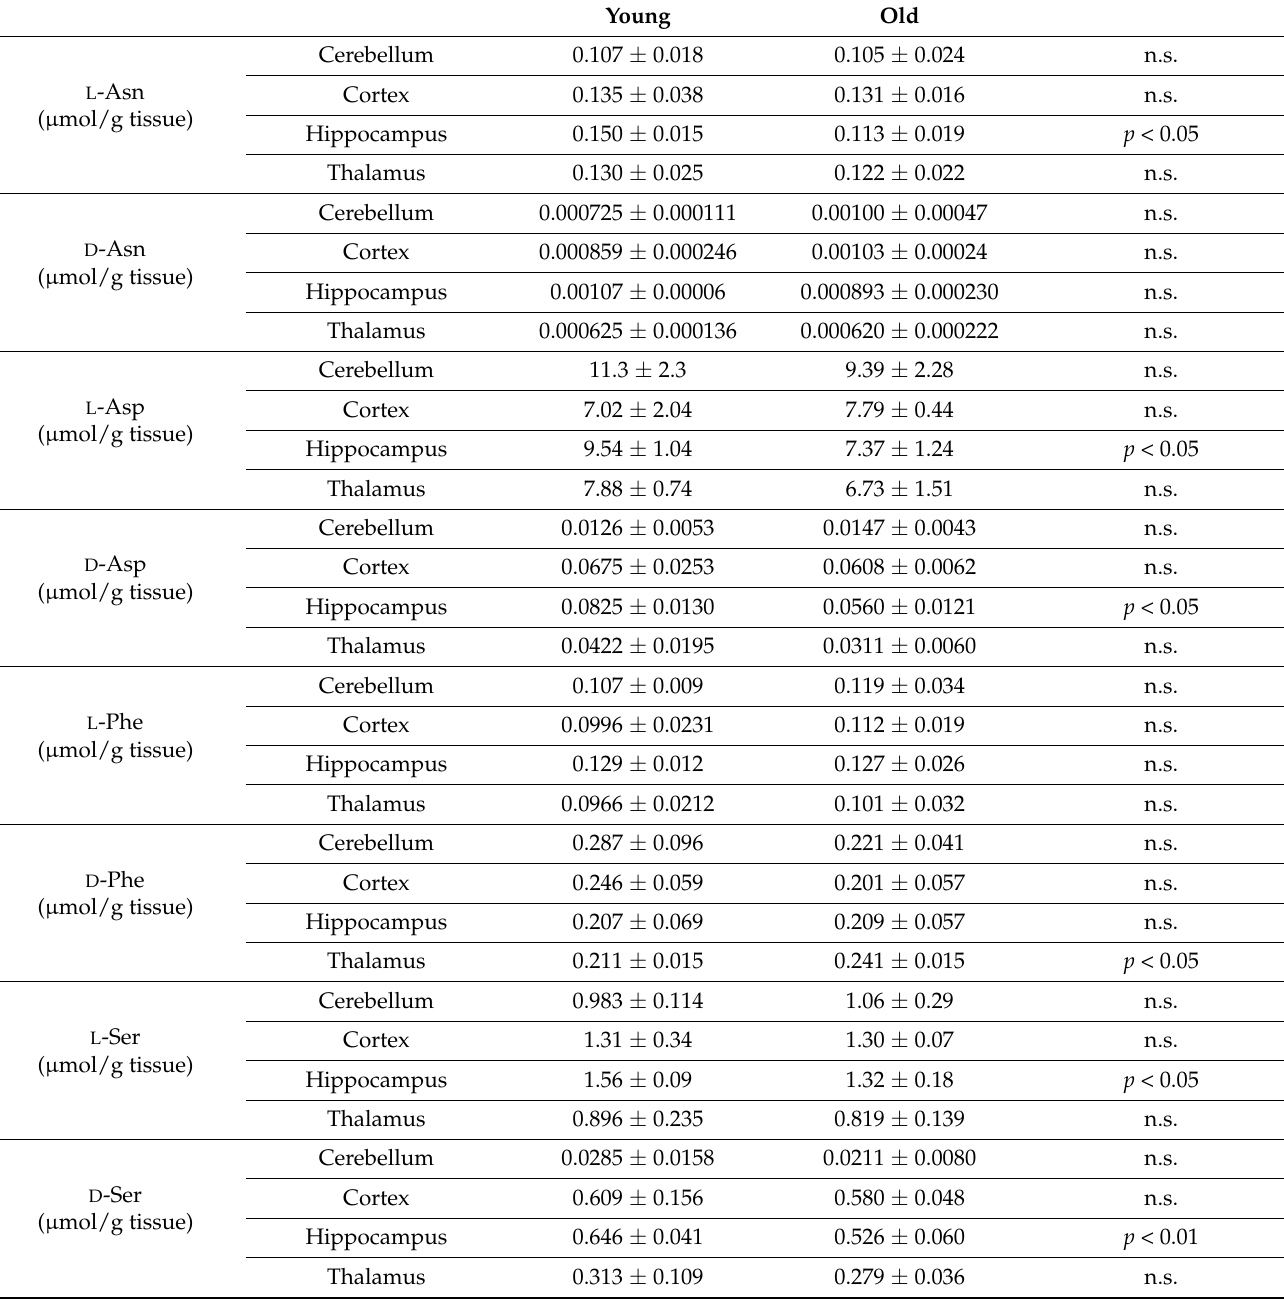
acid enantiomers in crude biological samples. Table 2. Absolute quantification of L - and D -amino acids in various brain regions from young and old mice. Metabolites were extracted from the cerebellum, cortex, hippocampus, and thalamus in young (3-month-old) and old (24-month-old) mice. After the derivatization with F-FDLA, the levels of L - and D -Asp, Asn, Ser, and Phe were absolutely quantified by LC/MS/MS. Amounts of L - and D -amino acids were calculated by using the standard curves obtained in Figure 5. The data is represented as means ± SD from young ( n = 5) and old ( n = 8)